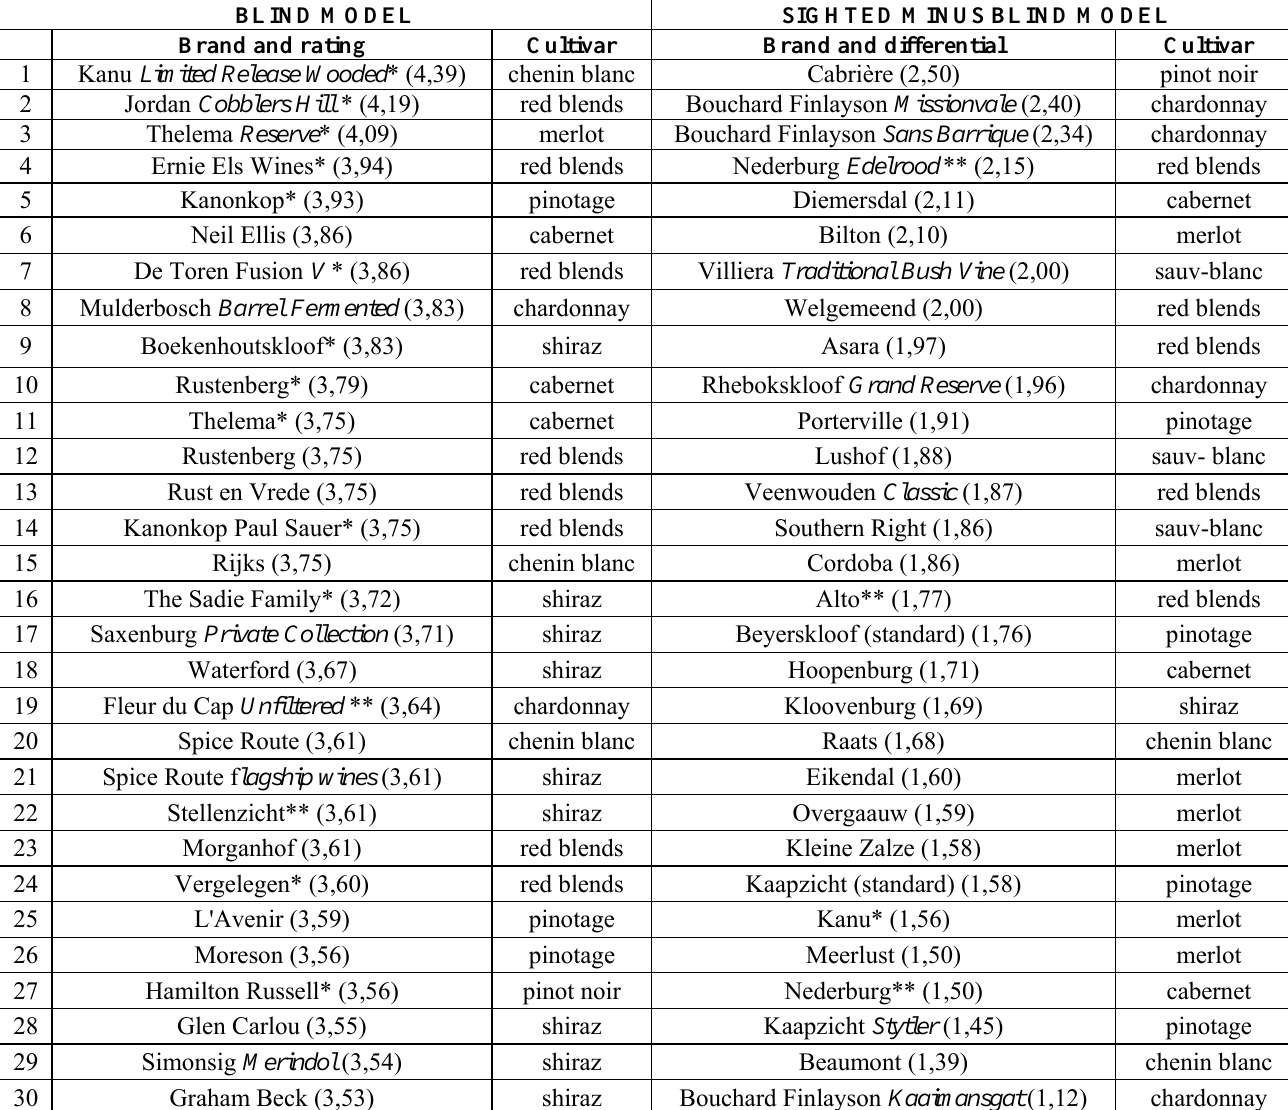
Table 12 : The top 30 brand effects identified for blind and sighted-to-blind assessments. Ratings for the blind and sighted-to- blind models are fitted values and are derived from text-cited equations 3 and 4, respectively. They should be noted in relation to the blind and sighted-to-blind score averages of 2,59 and 0,92. Note: a single and double asterisk denotes a winery featured either as one South Africa’s top rated wineries (*) or as one of the brands in the Distell stable (**) as per Table